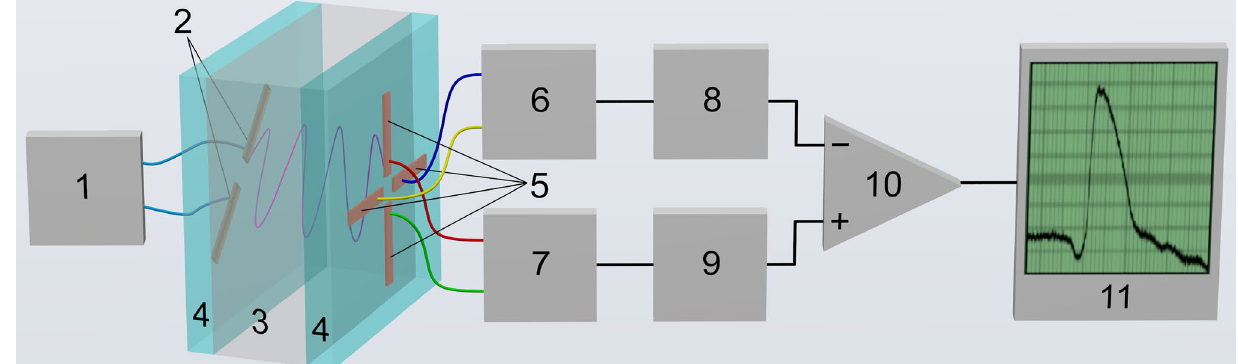
Figure 1. A simplified block diagram of the device for recording of RF wave polarization direction deviation. 1—a continuous wave transmitter 433.82 MHz, − 12 dBm; 2—a transmitting antenna; 3—an object under study; 4—a dielectric material; 5—orthogonal orientation quadrature antennas; 6—a channel X RF amplifier; 7—a channel Y RF amplifier; 8—X channel amplitude logarithmic detector; 9—Y channel amplitude logarithmic detector; 10—an instrumentation amplifier; 11—a registering device (X axis is time, Y axis is deviation). The antennas are shown as Hertz’s half-wave dipoles, it is clear that their real configuration is going to be